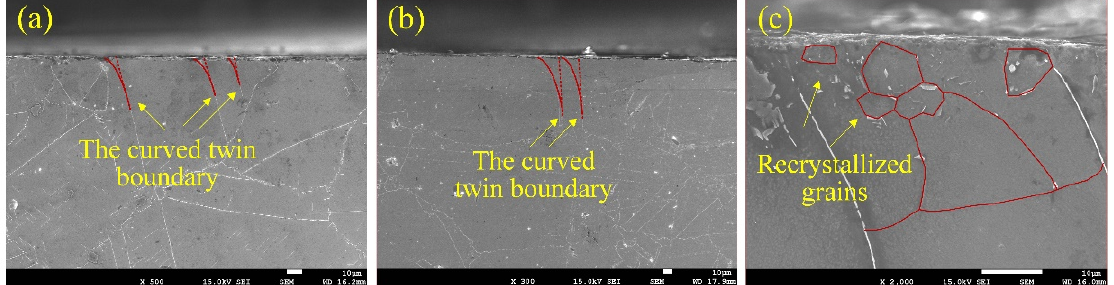
Figure 4. Microstructure of the GH4169 workpiece cross-section: ( a ) milling workpiece; ( b ) HT + M workpiece; ( c ) M + HT workpiece.